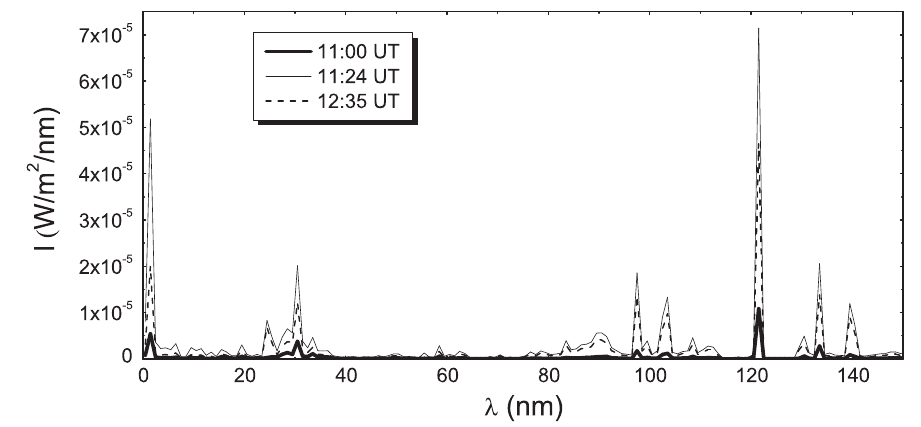
Fig. 4. Spectrum of the solar radiation for the unperturbed ionosphere (dotted line), at the maximum of the first flare (dashed line) and at the maximum of the second flare (solid